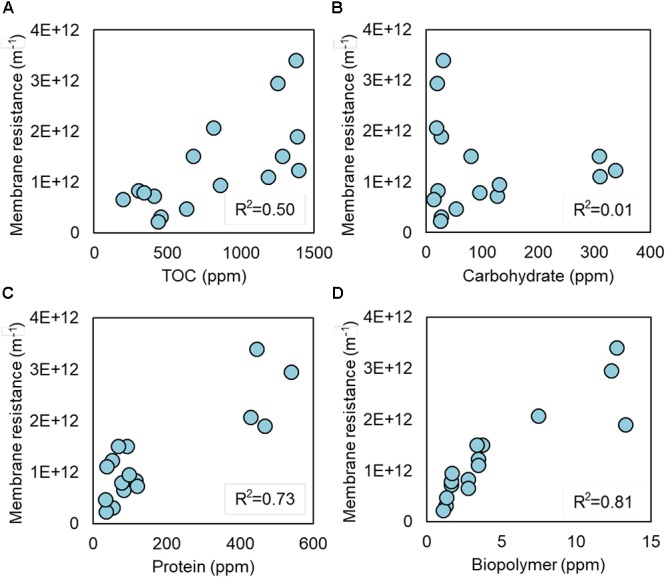
Linear correlation between membrane resistance and (A) TOC, (B) carbohydrate, (C) protein, and (D) biopolymer in SMP.